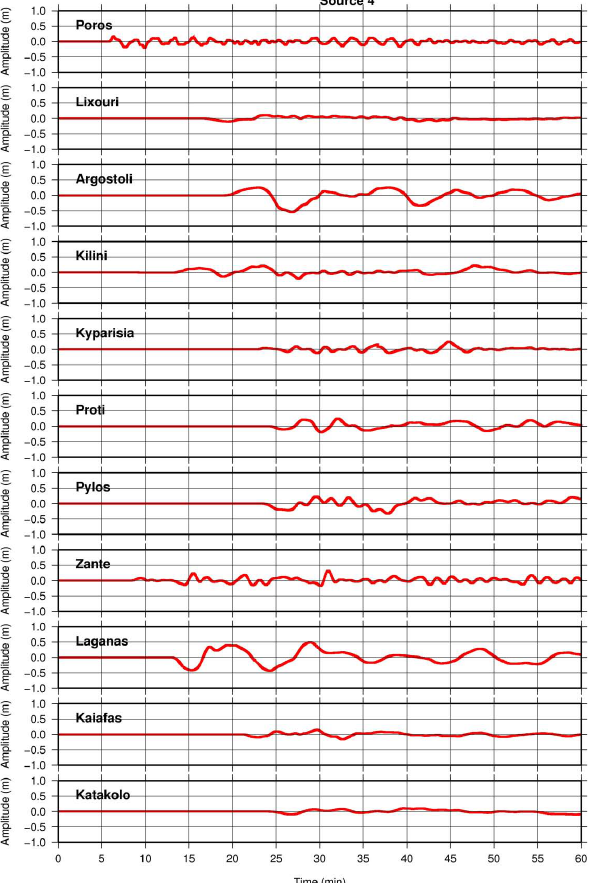
Fig. 11. Calculated mareograms at the locations shown in Fig. 4, for source 4 (Cephalonia North